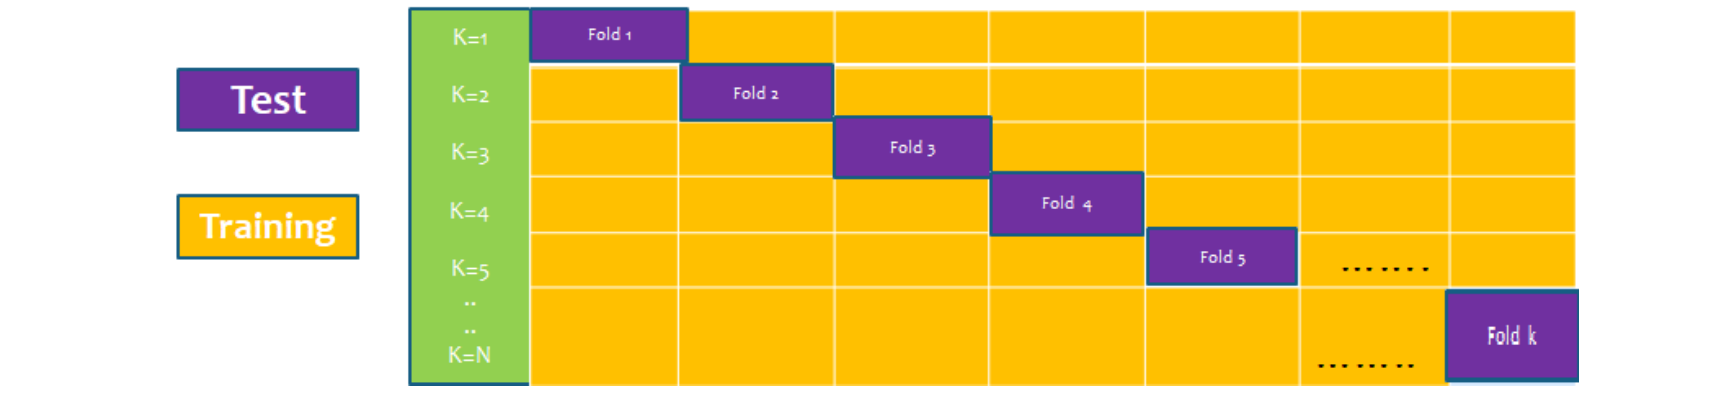
Figure 5. K-fold cross-validation (KFCV). Table 2. Result of 10-fold cross-validation based on the Random Forest classifier.